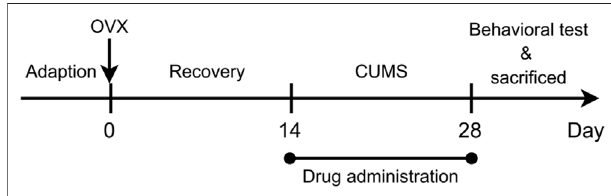
FIGURE 2 | Schematic representation of the experimental